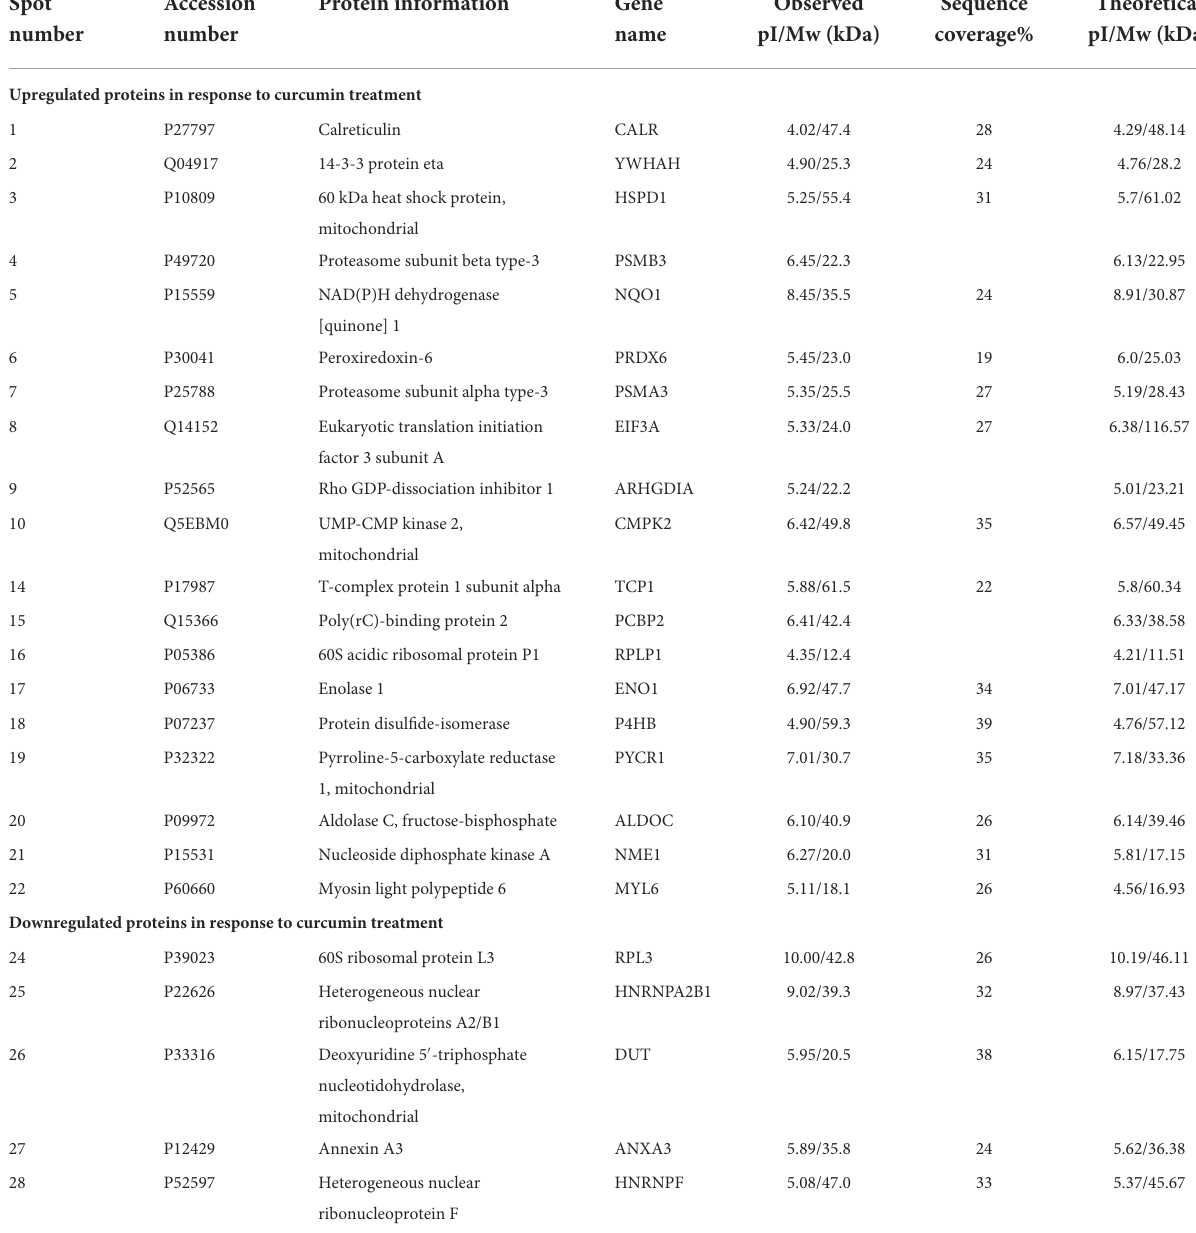
TABLE 1 Summary of differentially expressed proteins (DEP) in SW480 cells in response to 5-FU and curcumin